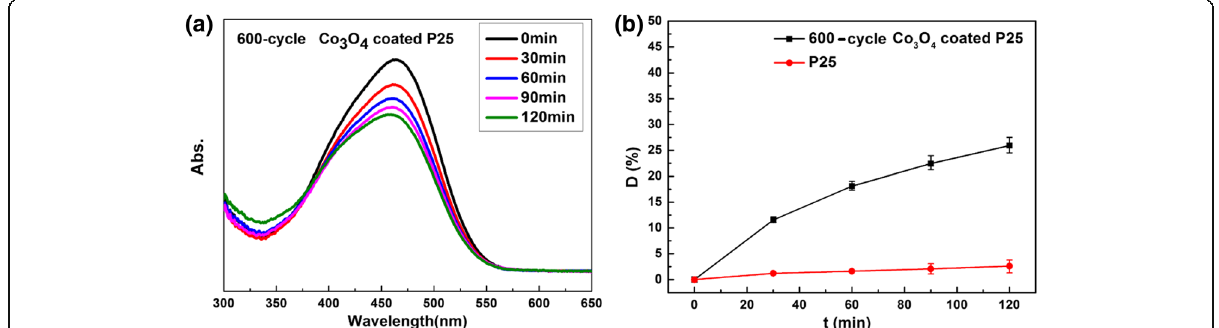
Fig. 9 Visible photocatalytic activity of 600-cycle Co 3 O 4 -coated P25 powders. a UV-visible absorption and b degradation curves of MO solution under visible light irradiation